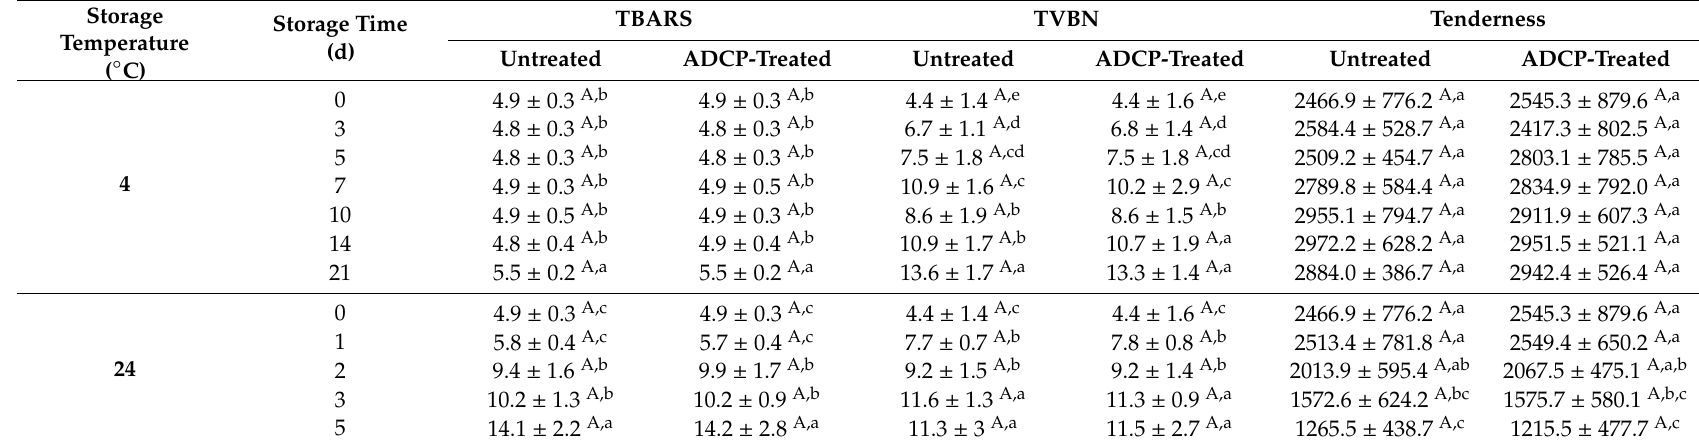
Data represent the means of 12 measurements with standard deviations. Means followed by the same lower-case letter within a column are not significantly di ff erent at each temperature at 4 ◦ C and 24 ◦ C ( p > 0.05. Tukey’s test), respectively. Means followed by the same capital letter within a row are not significantly di ff erent between samples in the same property at 4 ◦ C and 24 ◦ C. The ADCP treatment voltage and time were 24 kV and 3 min,